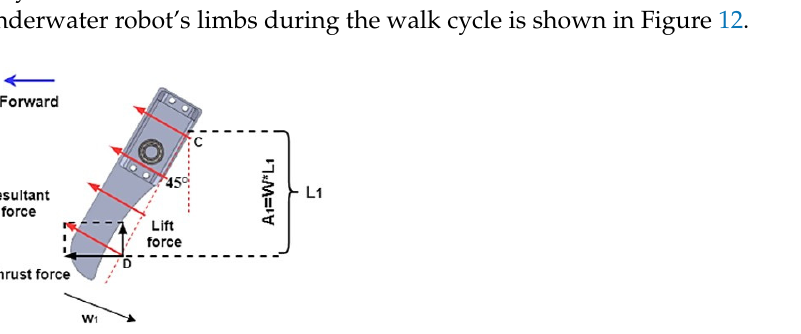
Figure 11. Schematic diagram of the forces during limb walking.